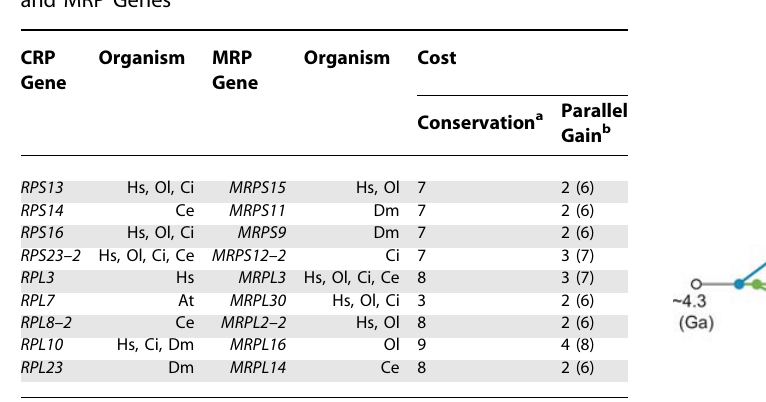
Table 1. Parsimony Analysis of Intron Positions Shared by CRP